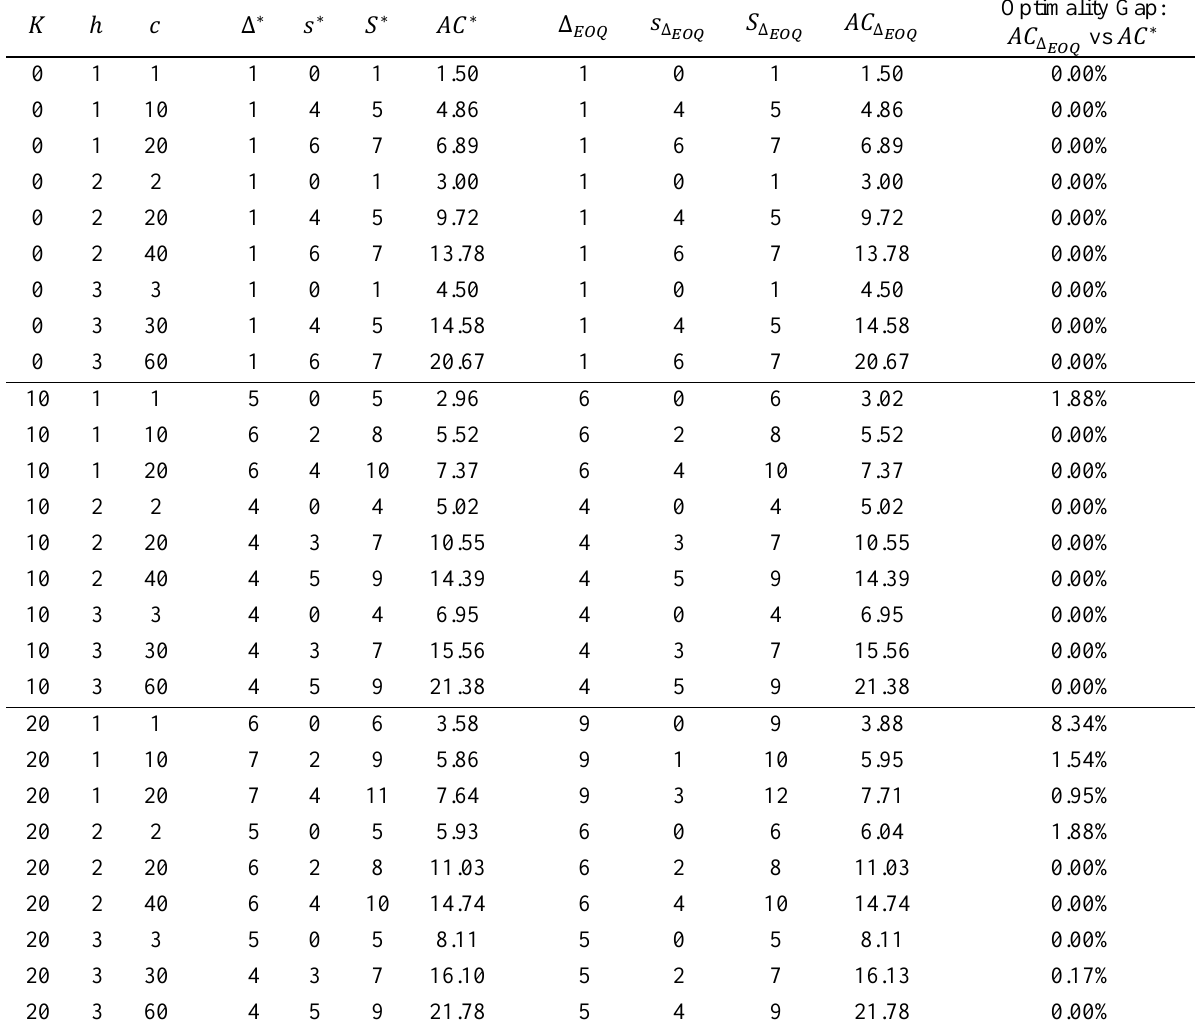
Table 8. Impact of system cost parameters for Uniform